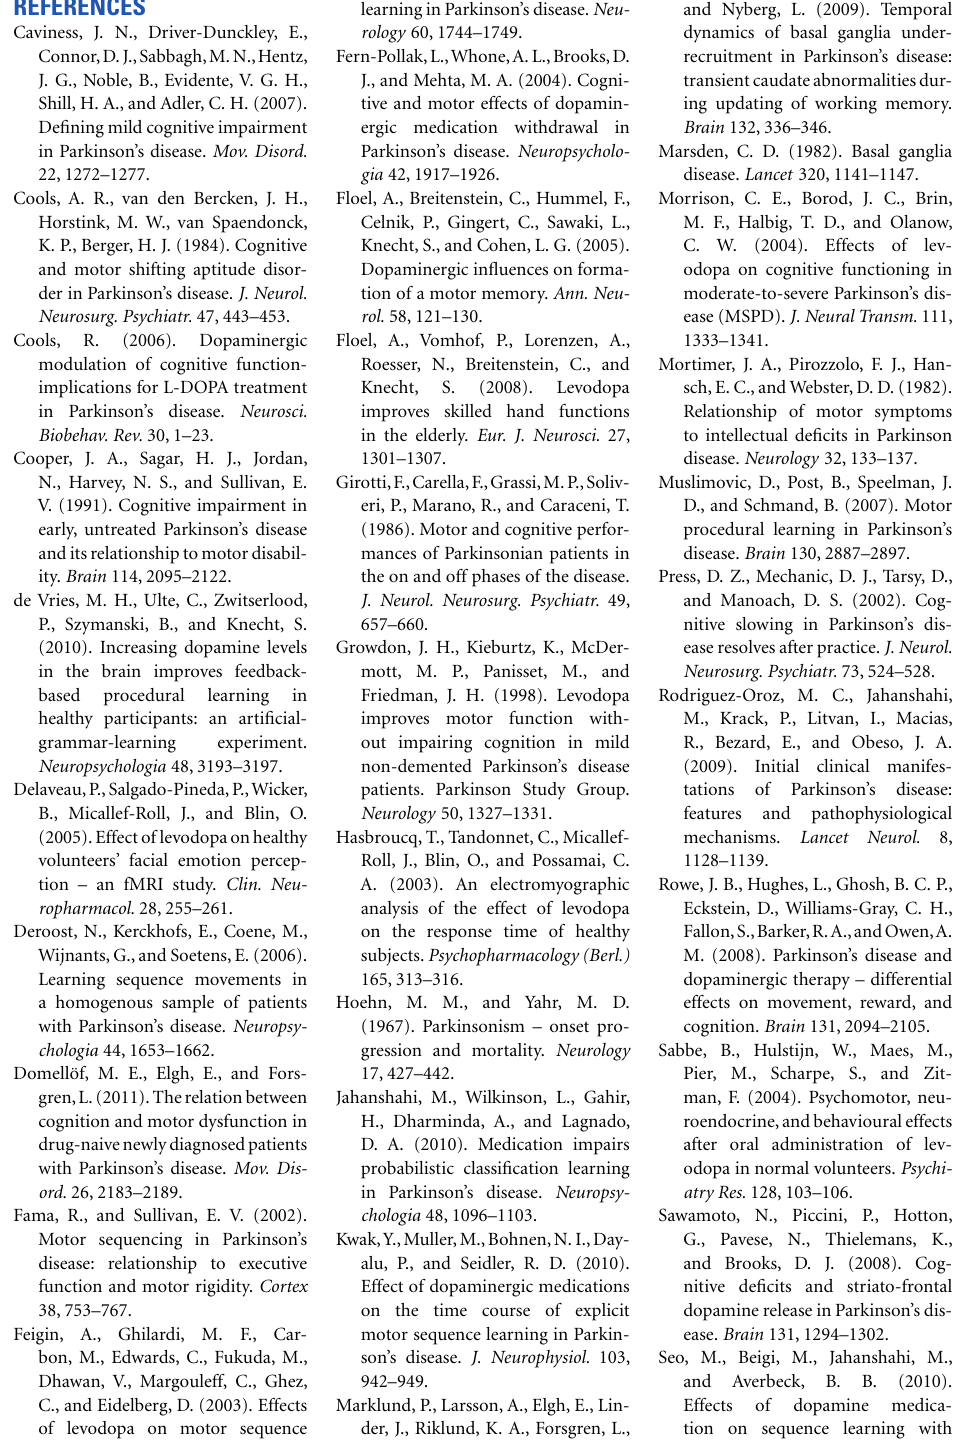
Table S1 |The major findings of multiple studies were classified into three functional domains, including motor, implicit knowledge acquisition and general cognitive functions. The disease stage at which the patients were tested, presence of dopaminergic medication effects on test results, tasks employed, major results observed and correlation analysis with other functional dimensions (when evaluated) were also